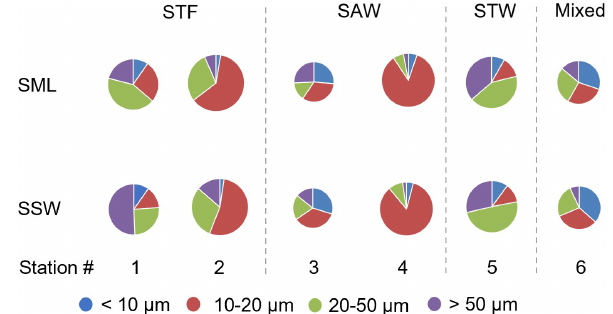
Figure 6. Pie charts showing the relative variation of phytoplank- ton size fraction in the sea surface microlayer (SML) and subsur- face water (SSW) at the six stations. The size of the pie is propor- tional to the total summed biovolume (in µm 3 L − 1 ) for phytoplank- ton > 5µm, with the coloured wedges corresponding to the different size fractions. Water mass type is indicated by the label at the top of the figure and separated by the grey vertical dashed